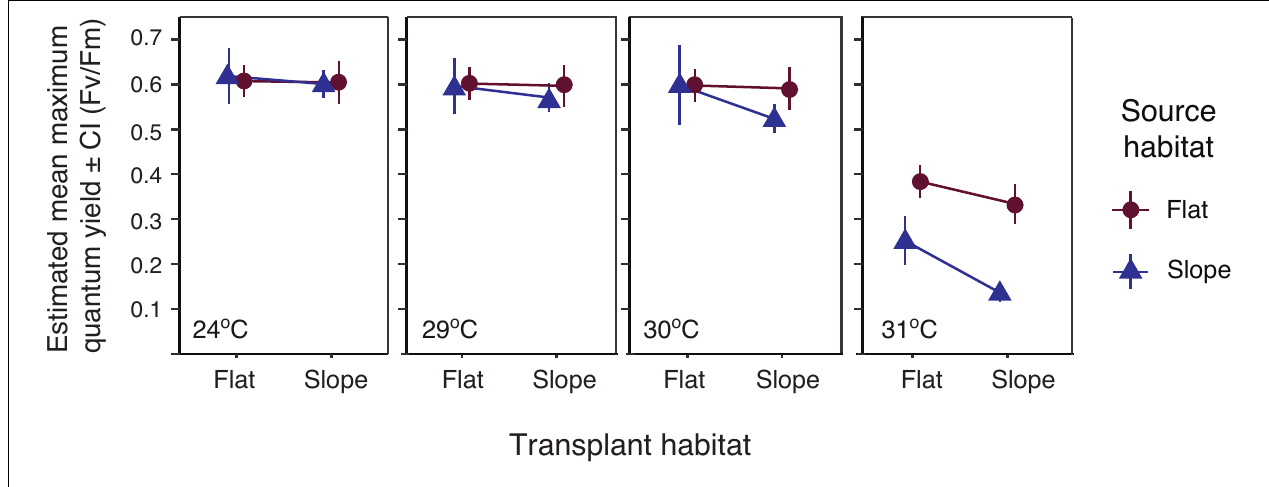
FIGURE 2 | Estimated mean maximum quantum yield ± SE after 14 days of ex situ heat stress at ambient and elevated temperatures, post 18-month reciprocal transplant. Error bars indicate range of possible means with 95% confidence. Significance table, Supplementary Table 8 , accompanies this figure.